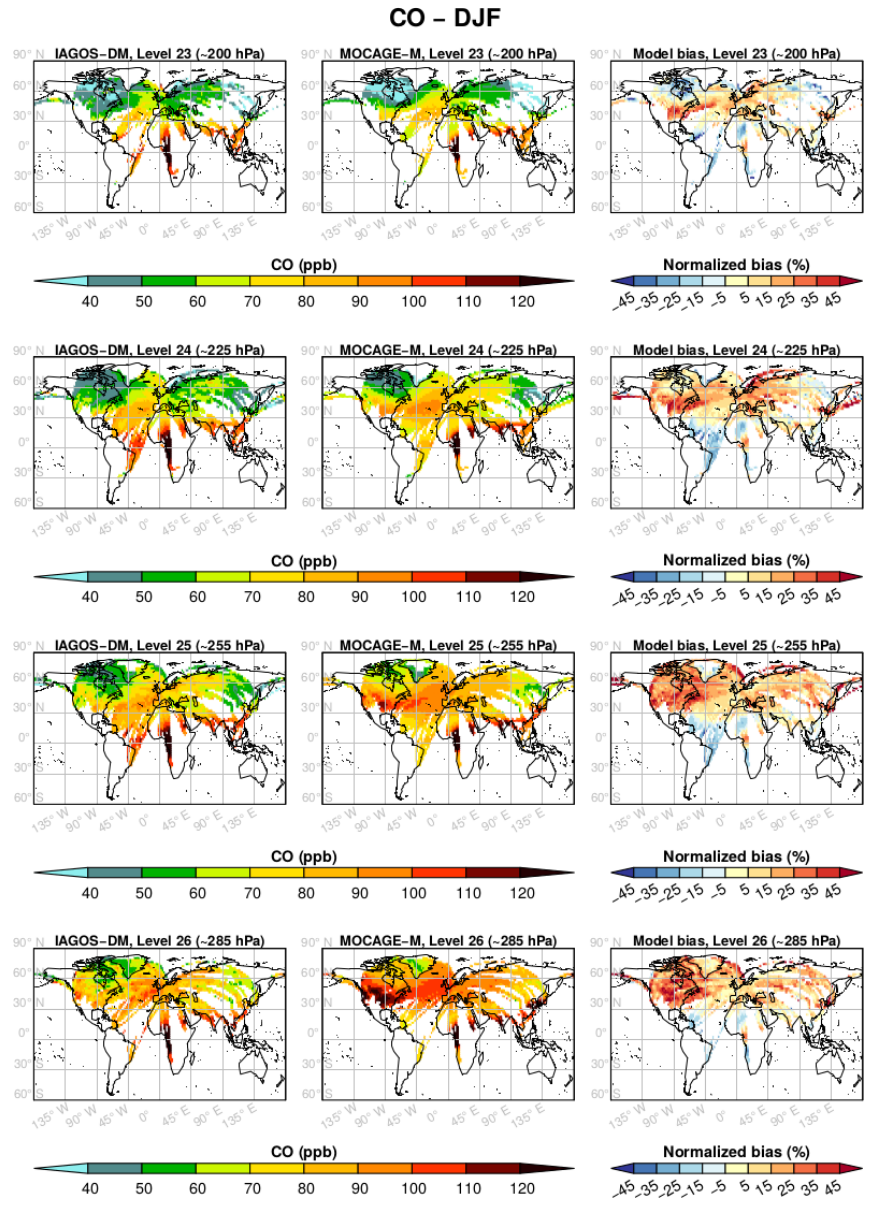
Figure A5. As Fig. 4 for boreal